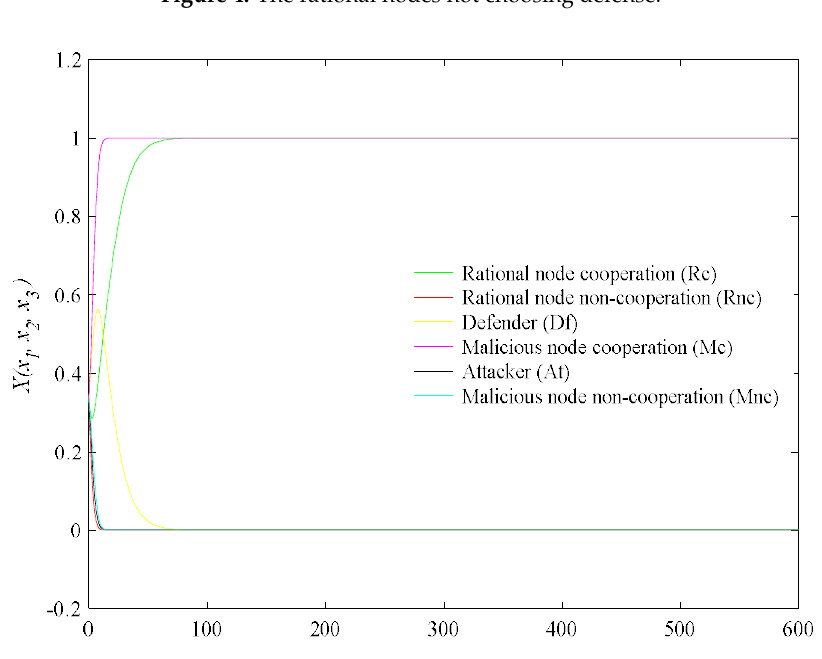
Figure 5. Half the rational nodes choosing defense.